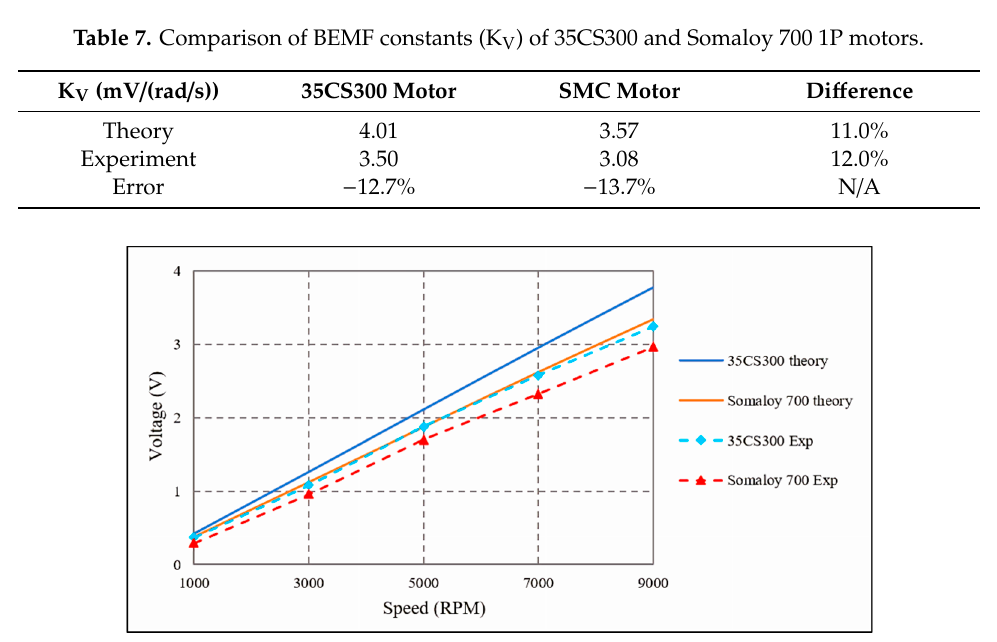
Figure 14. Voltage-speed curves of 35CS300 and Somaloy 700 1P motors.